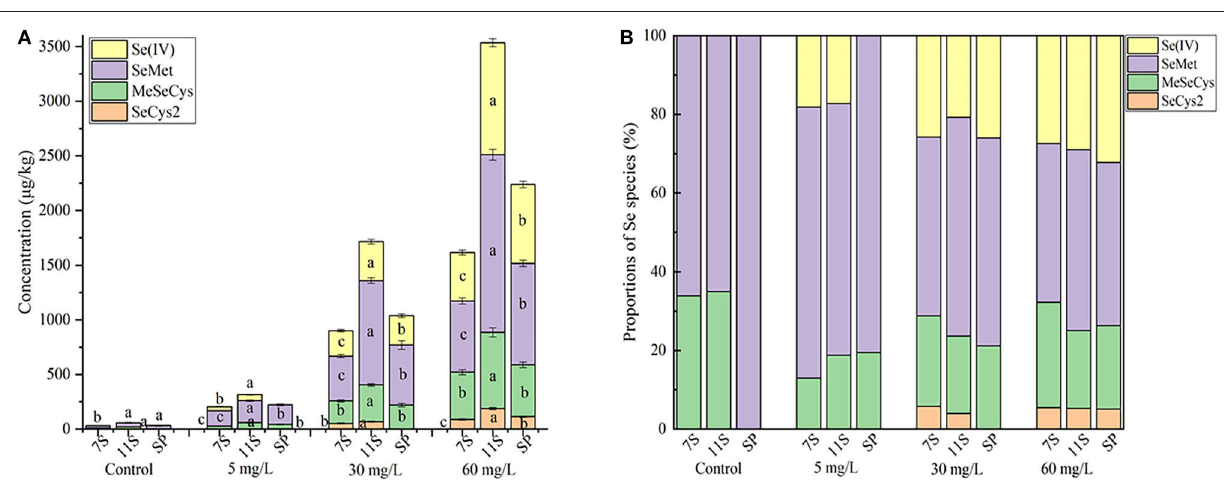
FTIR spectroscopy in all the samples are shown in Table 3 . The order of the secondary structure of proteins in all treatments was as follows: β -sheet, β -turn, random coil, and α -helix. Compared to those in RS, germination increased secondary